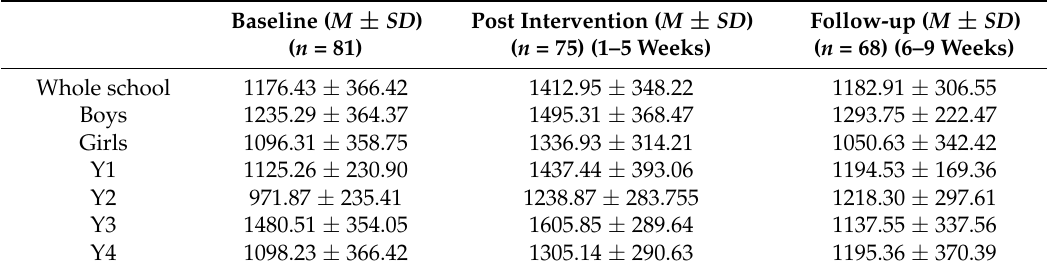
Table 2. Children’s pedometer step count during morning break times: baseline, post-intervention, and follow-up data collection points ( M ± SD